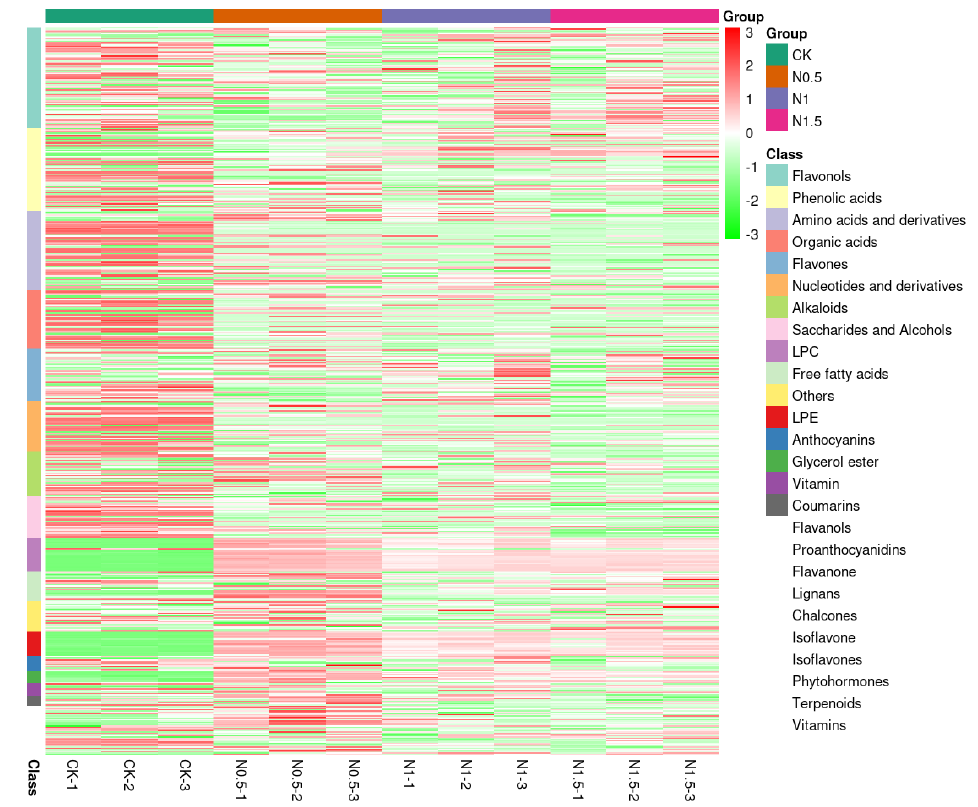
Figure 8. Heat map analysis of DAMs exhibiting fold changes of highly significant ( p < 0.05) DAMs grouped into more than 16 classes related to different treatment groups and CK. The four columns represent the treatment groups and CK samples (green: control, brown: N0.5 h, indigo: N1 h, magenta: N1.5 h; − 1, − 2, − 3 represent replications), with three further sub-divisions, one for each biological replicate in every sampled group. The correlation coefficients were utilized to classify different features determined by the Pearson correlation based on the averages/means as a clustering algorithm. The color gradient from red (3) to green ( − 3) depicts the number of compounds, presented as a relative fold